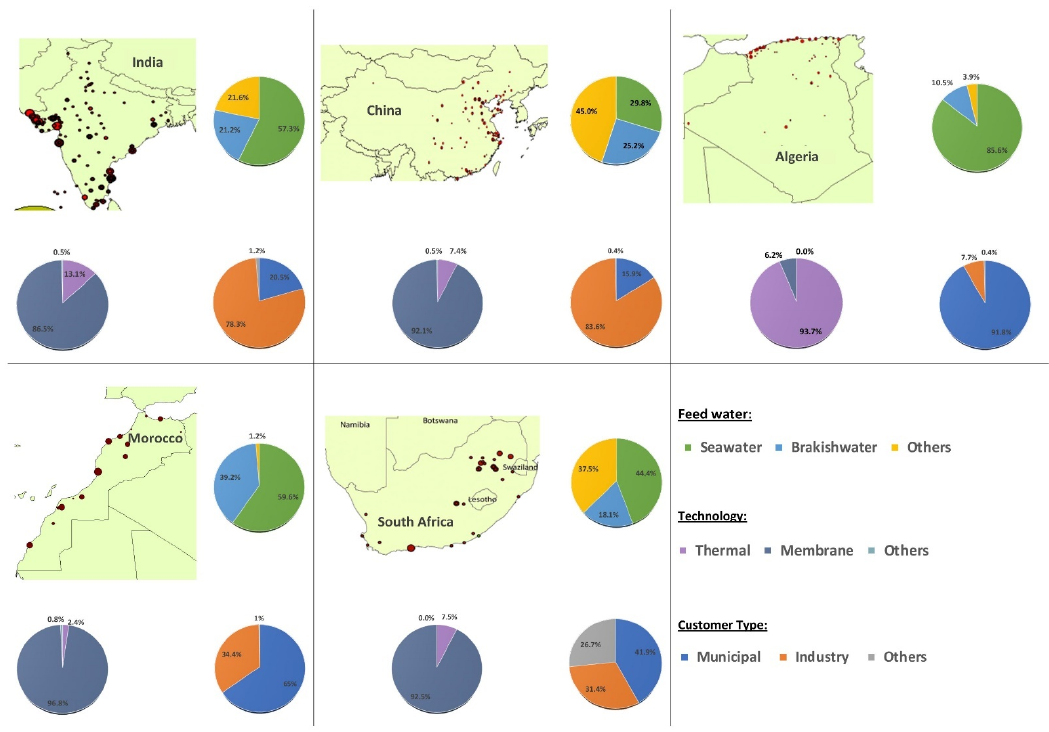
Figure 7. Country comparison of desalination use in India, Algeria, China, and South Africa [3].